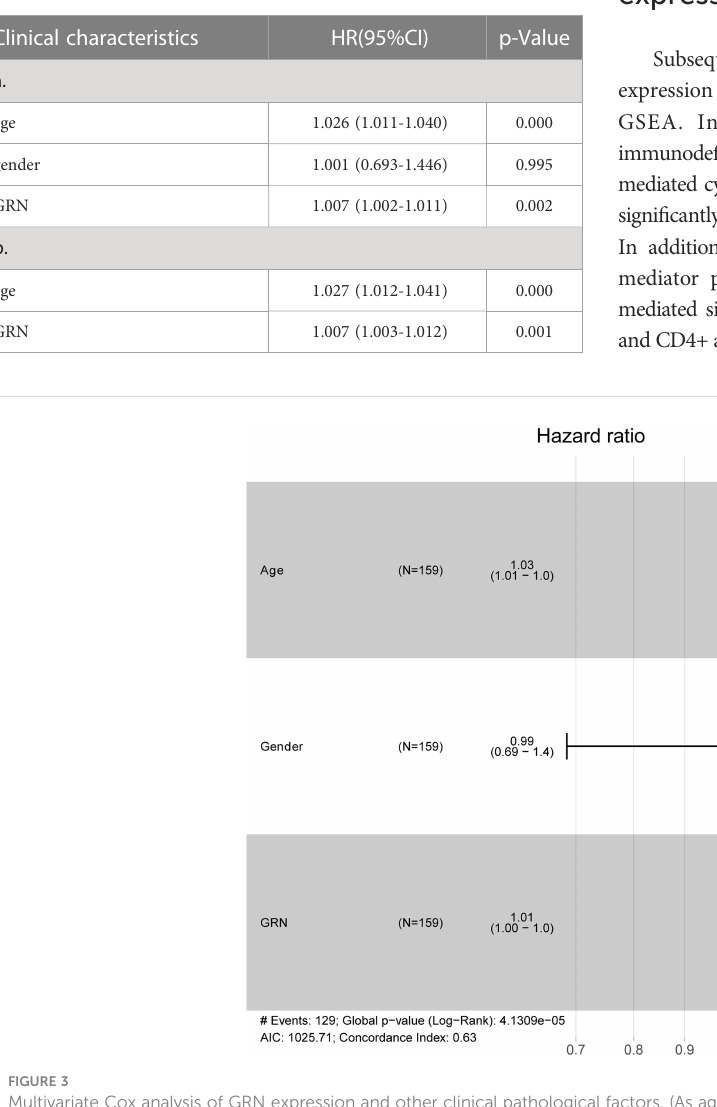
TABLE 1 a. Association with overall survival and clinicopathologic characteristic in TCGA patients using Cox regression. b. Multivariate survival using Cox